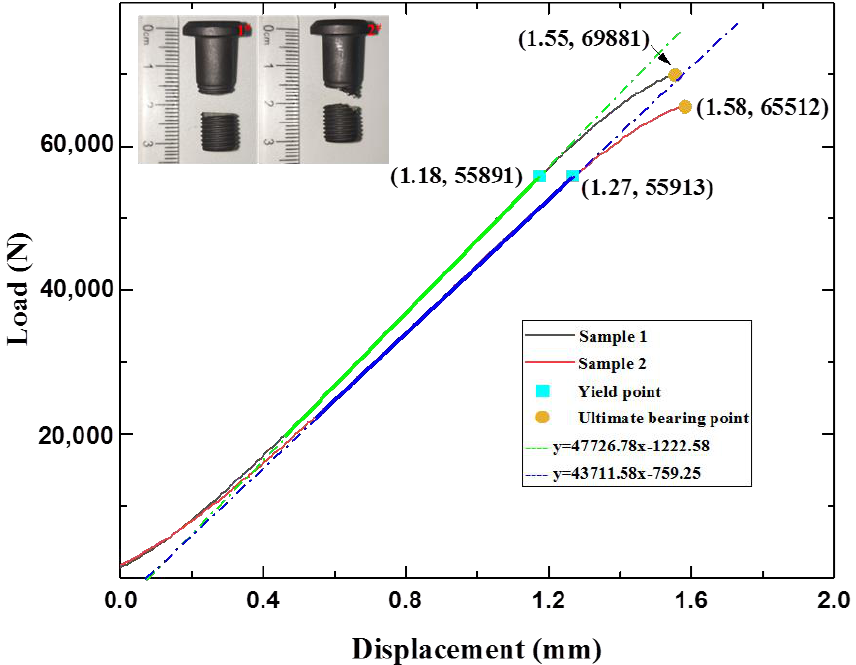
Figure 3. Load–displacement curves obtained by tensile Figure 3. Load – displacement curves obtained by tensile experiments.